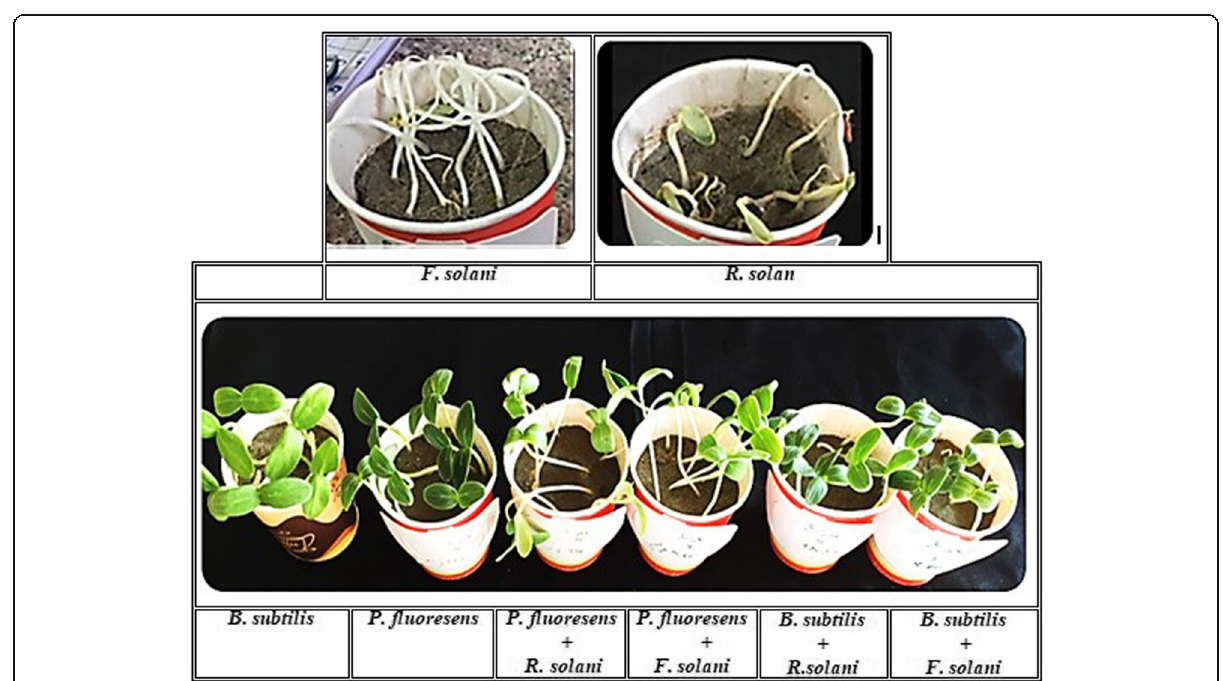
Fig. 7 Effect of B. subtilis and P. fluorescens on damping-off disease caused by F. solani and R. solani in the